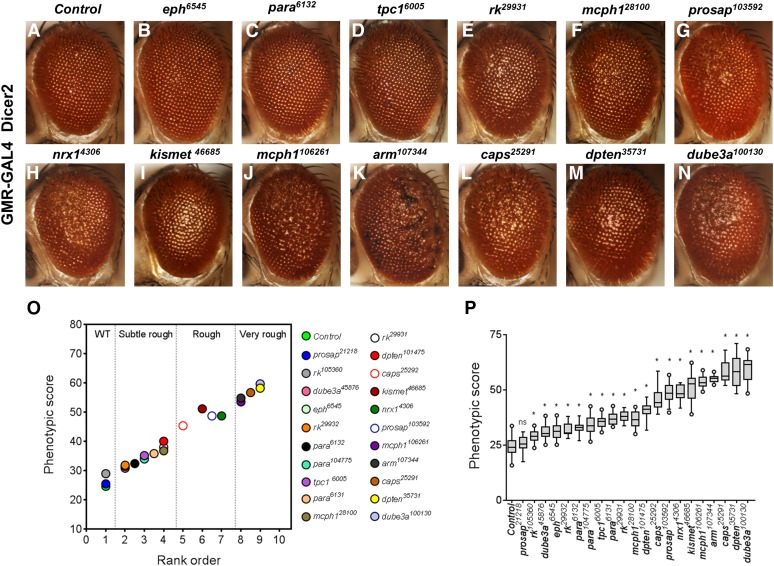
Analysis of Drosophila orthologs of human neurodevelopmental genes. (A–N) Representative bright-field microscope images of fly eyes displaying eye-specific knockdown of tpc1, eph, para, rk, mcph1, prosap, nrx-1, kismet, arm, caps, dpten, and dube3a genes from flies reared at 30°. Eyes of GMR-GAL4; Dicer2/+ control flies show normal ommatidial organization, while the eyes of flies with GMR-GAL4 driven RNAi knockdown of the 12 genes show disruption in the morphology of the eye. Note the variation in the severity of the eye phenotype for different genes. (O) Graph representing the mean phenotypic scores of control flies compared to the mean phenotypic scores for 21 RNAi lines with knockdown of neurodevelopmental genes (n = 9–30). The rank order of these fly lines was significantly correlated with the phenotypic scores (Spearman correlation coefficient = 0.99, P = 1.2 × 10−19). (P) Graph representing phenotypic scores of the 21 RNAi lines with GMR-GAL4 at 30°C is shown. The number of images analyzed for each genotype ranged from 9 to 30 (median of 20.5). Comparisons were made between each of the gene knockdowns to controls using a student t-test (*represents corrected two-tailed P < 0.001).